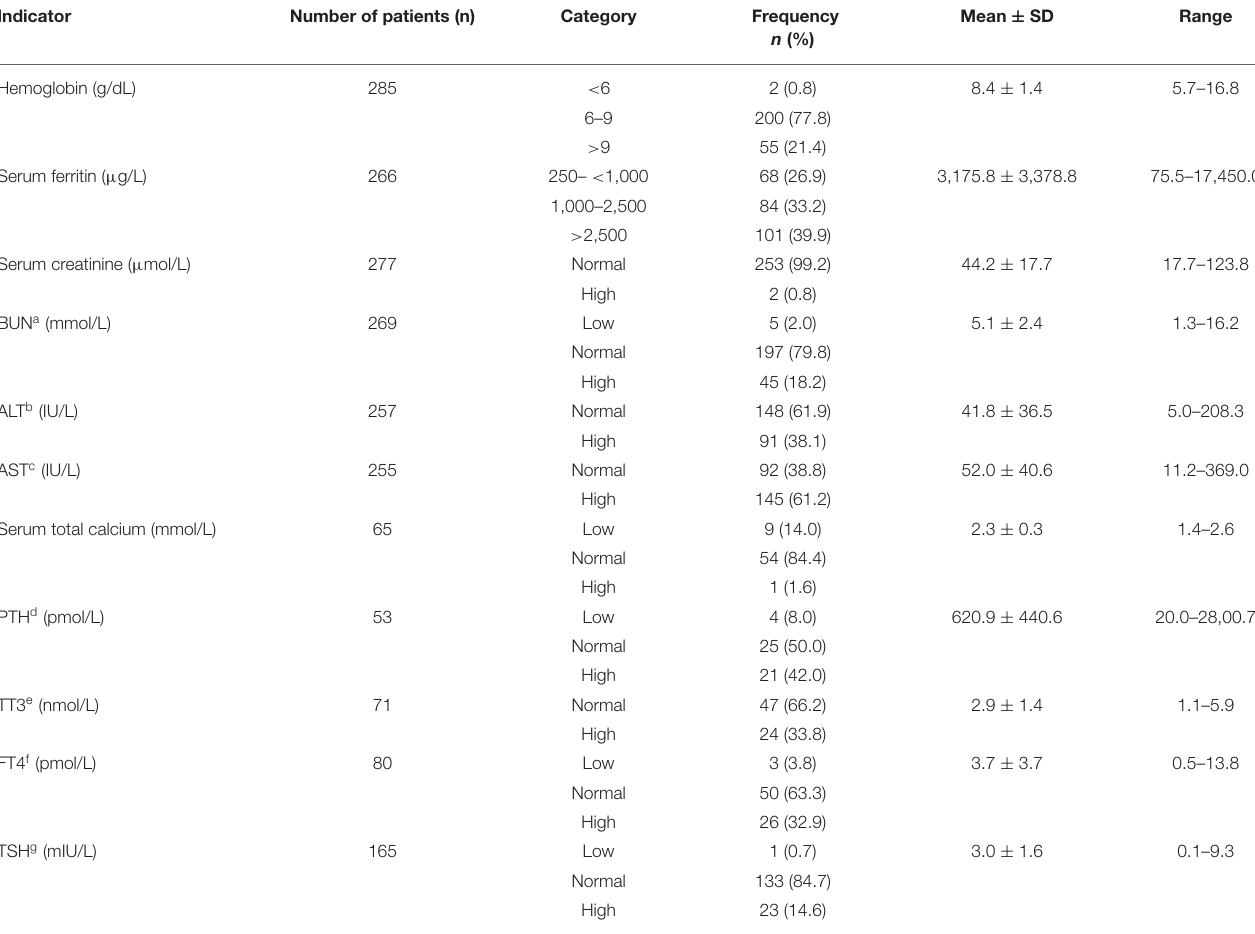
TABLE 2 | The biochemical, hematological, and hormonal baseline characteristics of β -thalassemia patients. Indicator Number of patients (n)